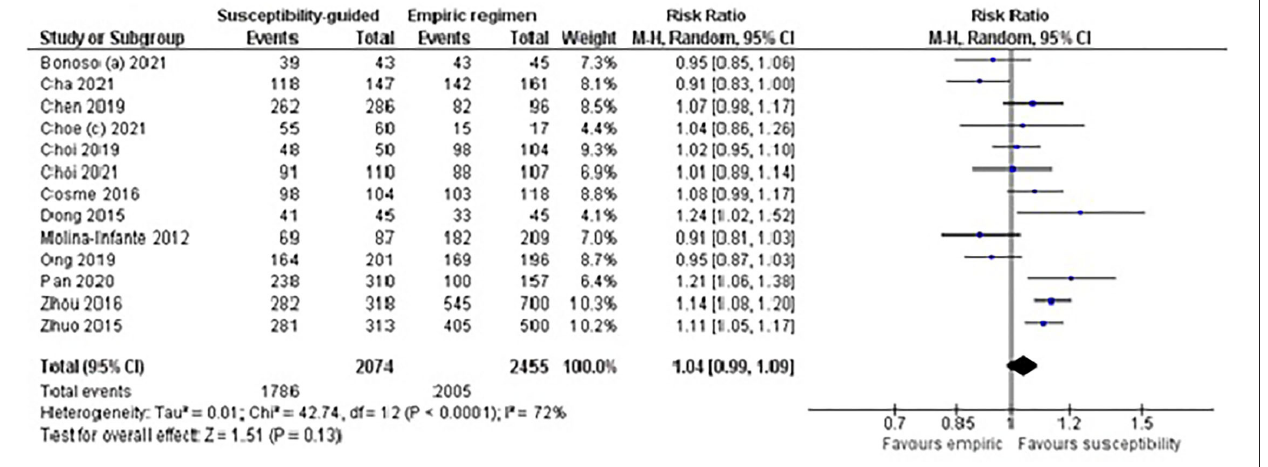
FIGURE 4 | Forest plot of studies comparing the effectiveness of susceptibility-guided and empirical treatment in naïve patients treated with a (bismuth or non-bismuth) quadruple therapy. M-H, Mantel–Haenszel; CI, confidence